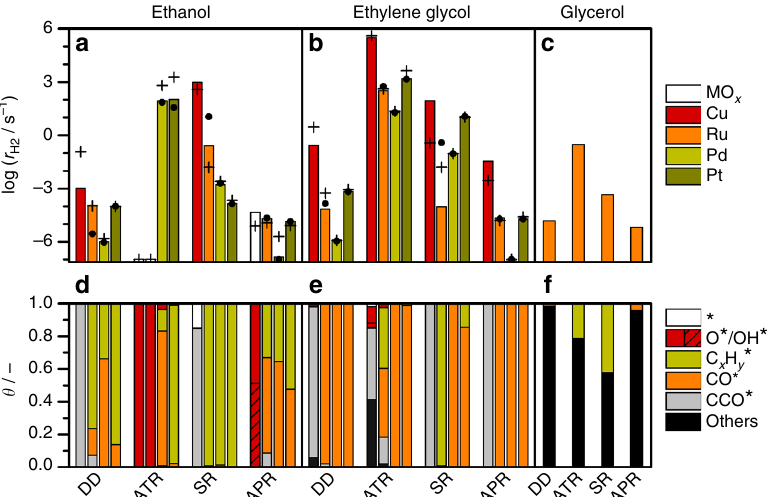
Fig. 5 Hydrogen production rate during decomposition and reforming. a DD, ATR, SR, and APR of ethanol and b ethylene glycol on Cu, Ru, Pd, and Pt. c Corresponding values for glycerol on Ru. The crosses show the result from MK-DFT, columns from MK-LSR, and dots from the MK-L1O method. White columns stand for reaction conditions where the oxygen content could change the existing catalytic phase. The surface coverages obtained with MK-DFT are shown on panels d -